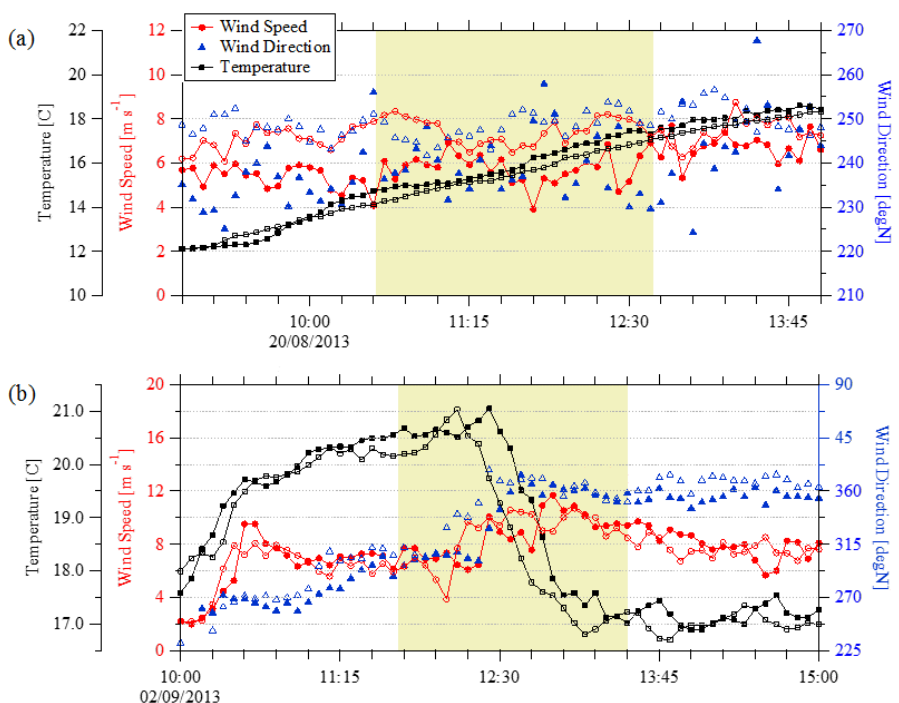
Figure 7. Wind speed (circles), direction (triangles), and temperature (squares) as recorded by two WBEA towers. Open symbols are at AMS03 (57.032 ◦ N, 111.505 ◦ W) at a height of 167m above ground level, and closed symbols are at AMS05 (56.969 ◦ N, 111.482 ◦ W) at a height of 75m above ground level. The shaded area shows the duration of the flight box on 20 August (a) and 2 September (b) . Times are LT